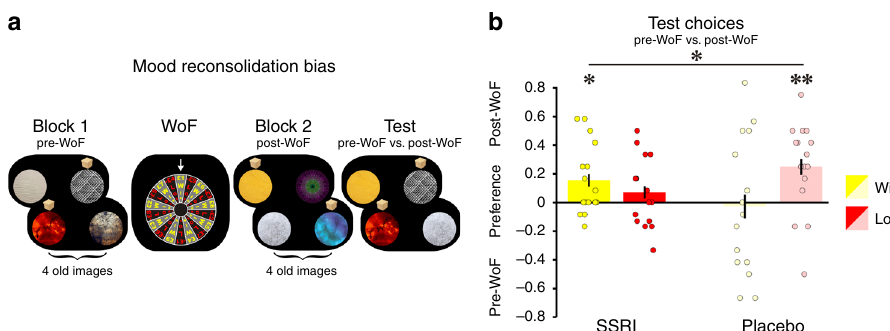
Fig. 4 SSRIs modulate the impact of mood on reconsolidation. a In addition to novel images, each block comprised interleaved trials involving choices between familiar images from previous sessions. Outcomes were not revealed on such trials to prevent further learning, and subjects had to rely on previously acquired knowledge when making choices. On session IV, a subset of images re-appeared as interleaved trials either before (pre-WoF), or after (post-WoF), the mood manipulation. The fi nal test block comprised an additional set of trials comparing these images (re-appeared pre-WoF vs. re- appeared post-WoF). By design, such images only differed in the mood state under which subjects retrieved learned reward associations from memory when choosing. Note these images had initially been learned in the same block, unbiased by mood during session III (cf. Methods for details). b Proportion of test block choices between images that had been encountered without feedback during preceding reconsolidation in different blocks, i.e., pre-WoF or post-WoF. This analysis involved choices between images with objectively similar reward probabilities, i.e., high vs. high and low vs. low, and preference is computed as difference between percent choices of post-WoF images and pre-WoF images, as a function of WoF outcome. Contrasting a mood bias on learning, subjects preferred images that re-appeared post-WoF, irrespective of whether the WoF was won or lost. However, this effect was differentially modulated by the drug (drug × valence: F 1,60 = 4.8, p = 0.032, n = 64), with a signi fi cant preference for images encountered after winning F 1,15 = 6.4, p = 0.023) but not losing the draw in the SSRI group, and a preference for images encountered after losing (F 1,15 = 10.1, p = 0.006) but not winning the draw in the placebo group. ** p < 0.01, * p < 0.05. Error bars indicate